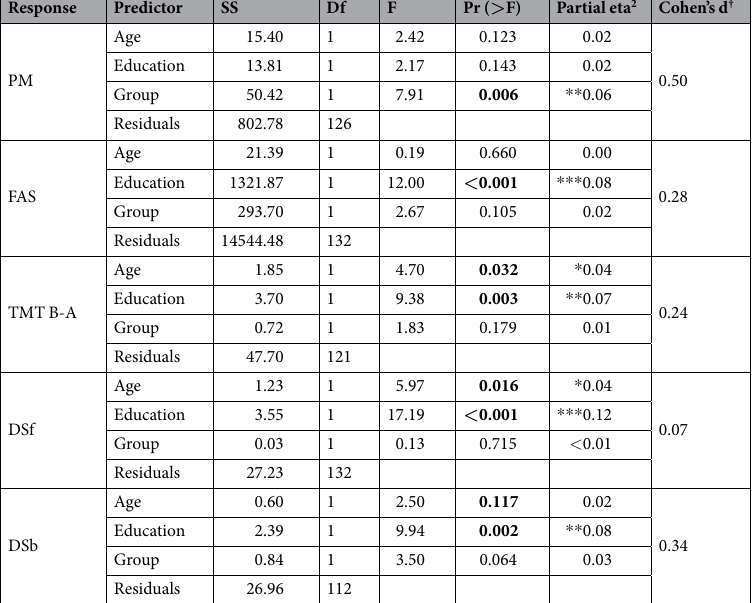
Table 3. ANCOVA analyses. † Computed on adjusted scores; Significance levels: * p < 0.05; ** p < 0.01; *** p < 0.001. PM: Prose Memory test; FAS: phonemic fluency test; TMT B-A: trial making test, log-transformed difference between B and A subtests; DSf: digit span forwards; DSb: digit span backwards; SS: sum of squares; Df: degrees of freedom.